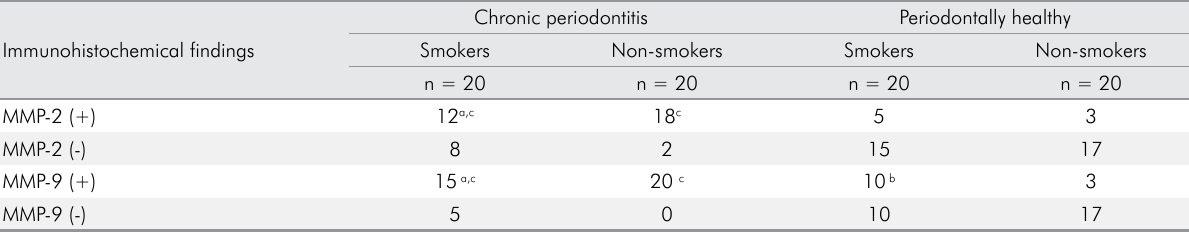
Table 3. Distribution of immunohistochemical findings of smoker and non-smoker chronic periodontitis and periodontally healthy subjects.